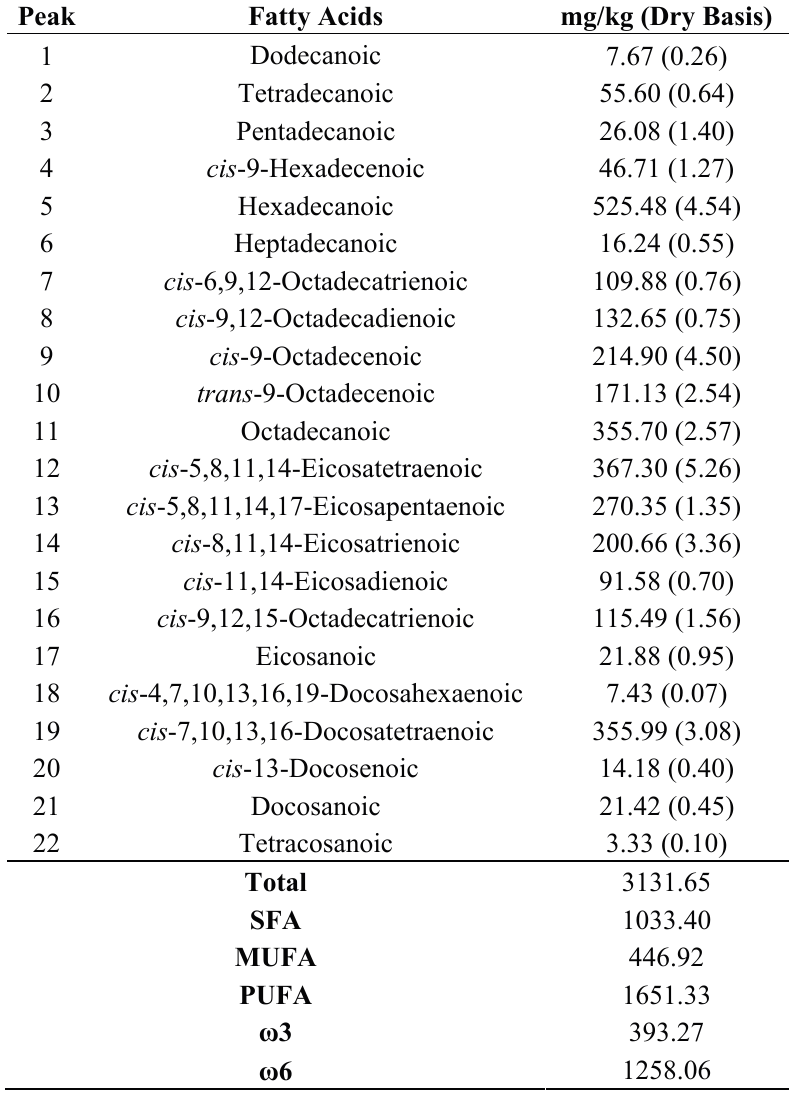
Table 1. Fatty acids composition of the methanol extract from the digestive gland of A. depilans a